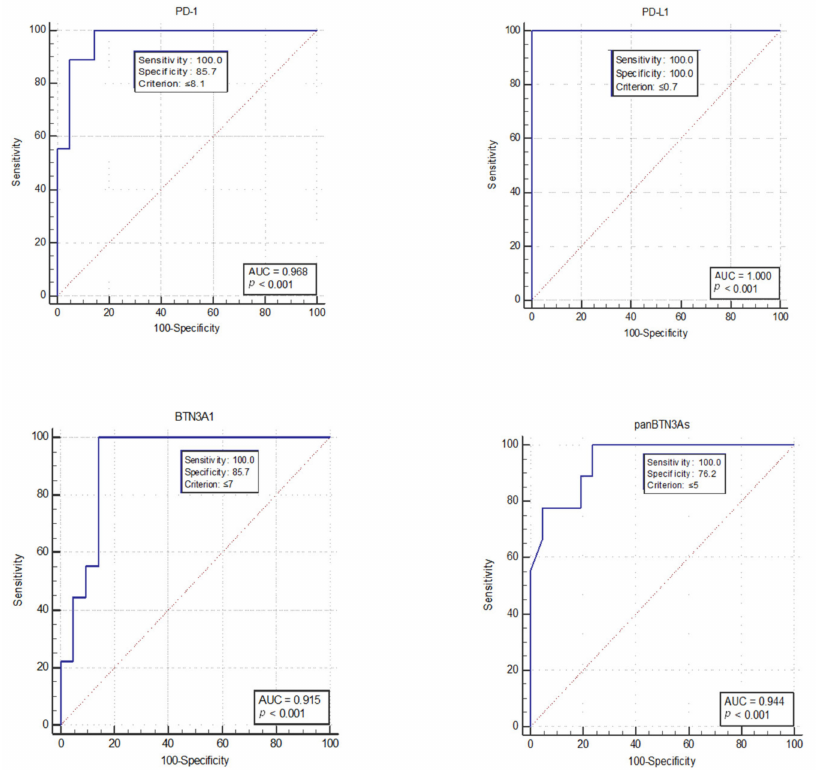
Figure 2. Analysis by ROC curves of circulating levels of sPD-1, sPD-L1, sBTN3A1, and